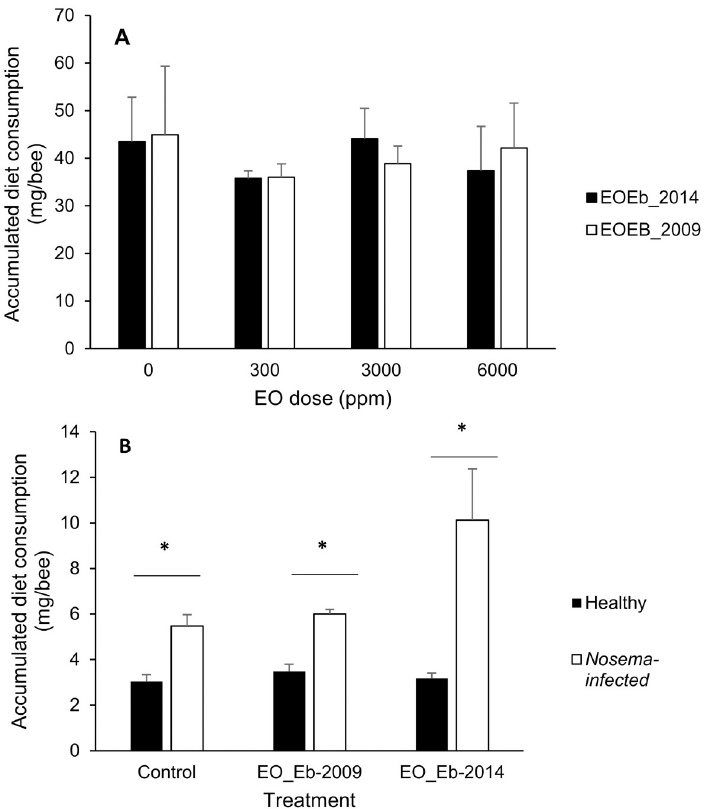
Fig 1. Cumulative food consumption by honeybees fed on diets enriched with E . buniifolium EO. EOs from different harvest times (2009 and 2014) were tested: on healthy honeybees at different doses ( A ) and on healthy and Nosema -infected honeybees at 6000 ppm ( B ). No differences were found among consumption on different diets by healthy bees (ANOVA, GLM, p > 0.05, A ). � indicates significant differences between bar pairs (ANOVA, GLM, p < 0.01; B